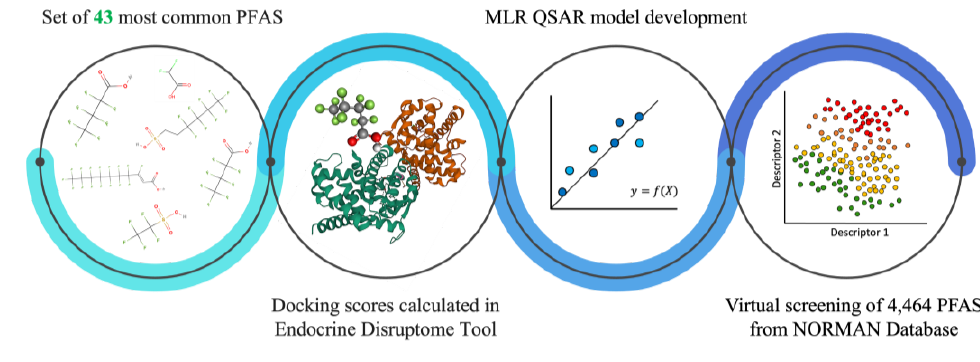
Figure 1. Workflow of research.